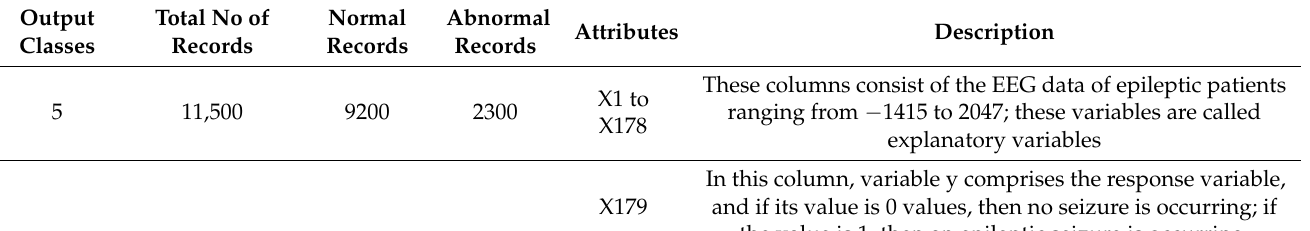
Table 2. Details of the Epileptic Seizure